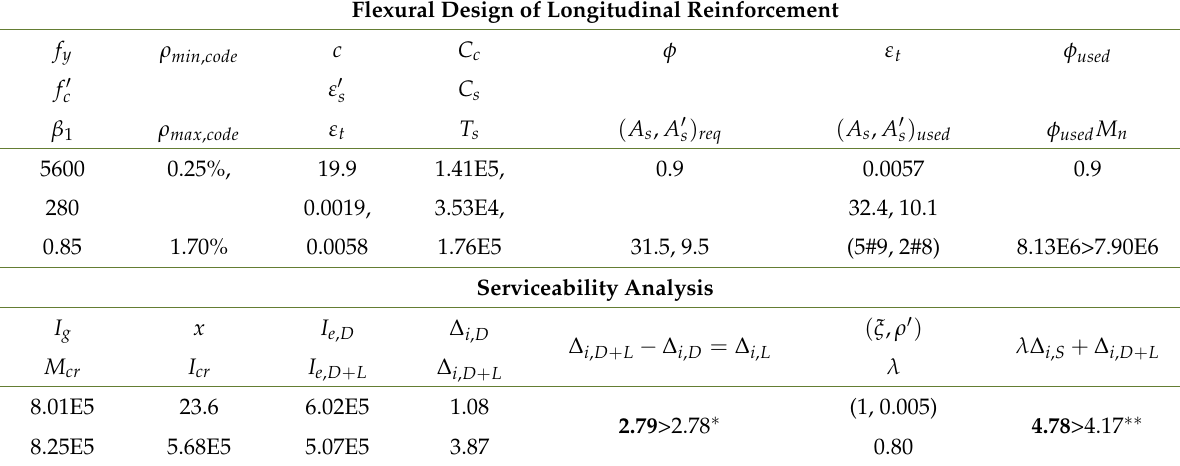
Table 4. Flexural design and serviceability analysis with f y = 5,600 kgf/cm 2